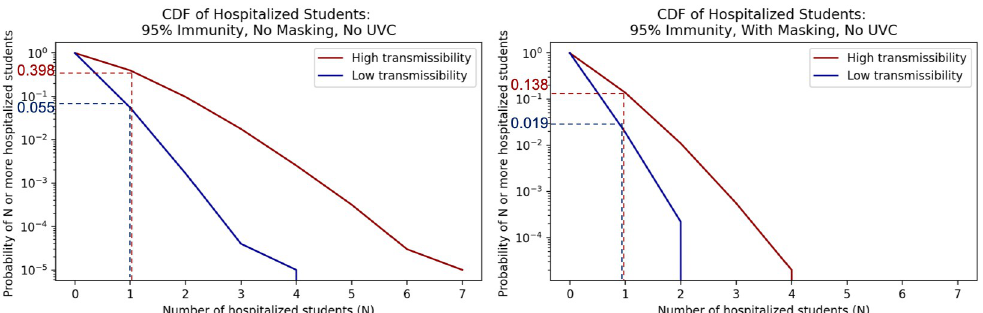
Fig 6. Inverse cumulative density functions for the total number of students hospitalized under the different scenarios. Each graph shows the curve of the probability of exceeding a given number of hospitalizations.